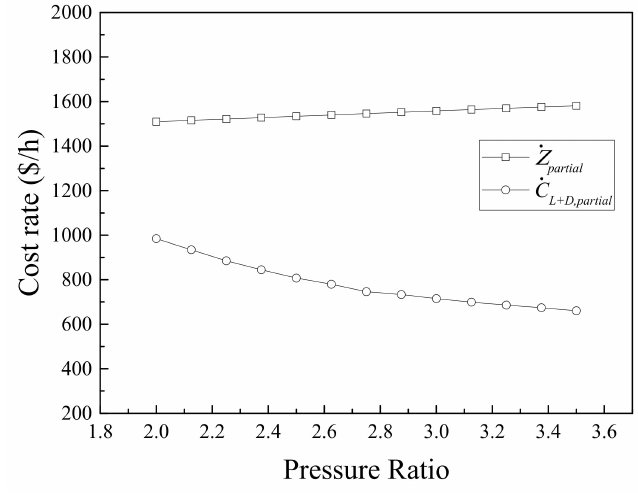
Figure 11. Effects of β on Z and C L + D with the partial-cooling cycle. C component is the total cost of each component, such as the compressor, the cooler, the turbine, the recuperator, and the Na-sCO 2 heat exchanger. As seen in Figure 12, the total cost of the Na-sCO 2 heat exchanger barely changed with β maintaining a value of around 1570–1580 USD/h. The total costs of other components are shown in Figure 12. Turbines and compressors had a lower cost at lower β . By contrast, the total cost of recuperators decreased with increasing β . With higher β , the exergy of the working fluid at the outlet of turbine decreased, as did the energy needed for recuperation. Therefore, the total cost of recuperator was reduced.